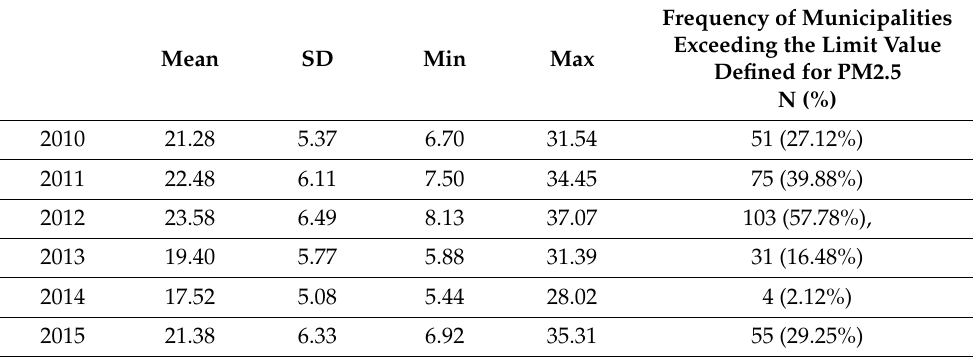
Table 1. Summary of particulate matter (PM, annual mean) concentration in µ g/m 3 in the study period. SD = standard